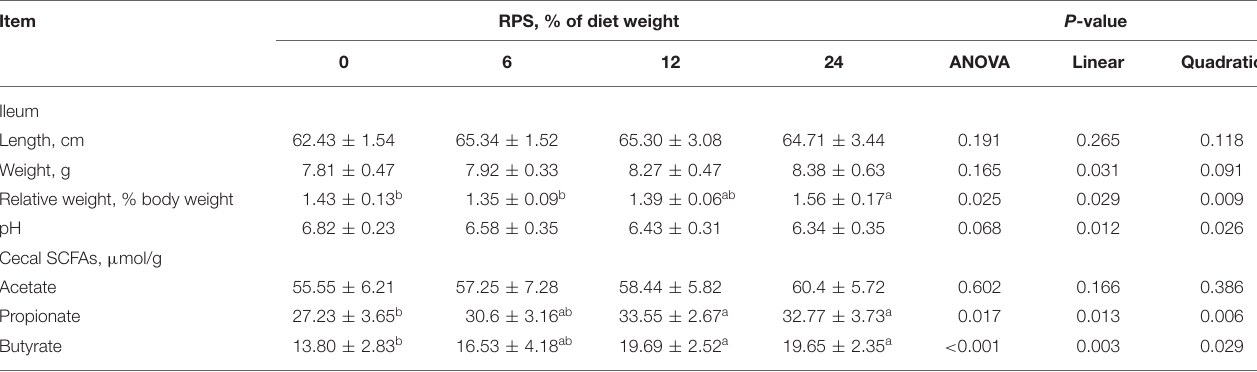
TABLE 4 | Effect of dietary raw potato starch (RPS) supplementation on the ileal physiochemical environment and cecal short chain fat acids (SCFAs) level in 14 day-old meat